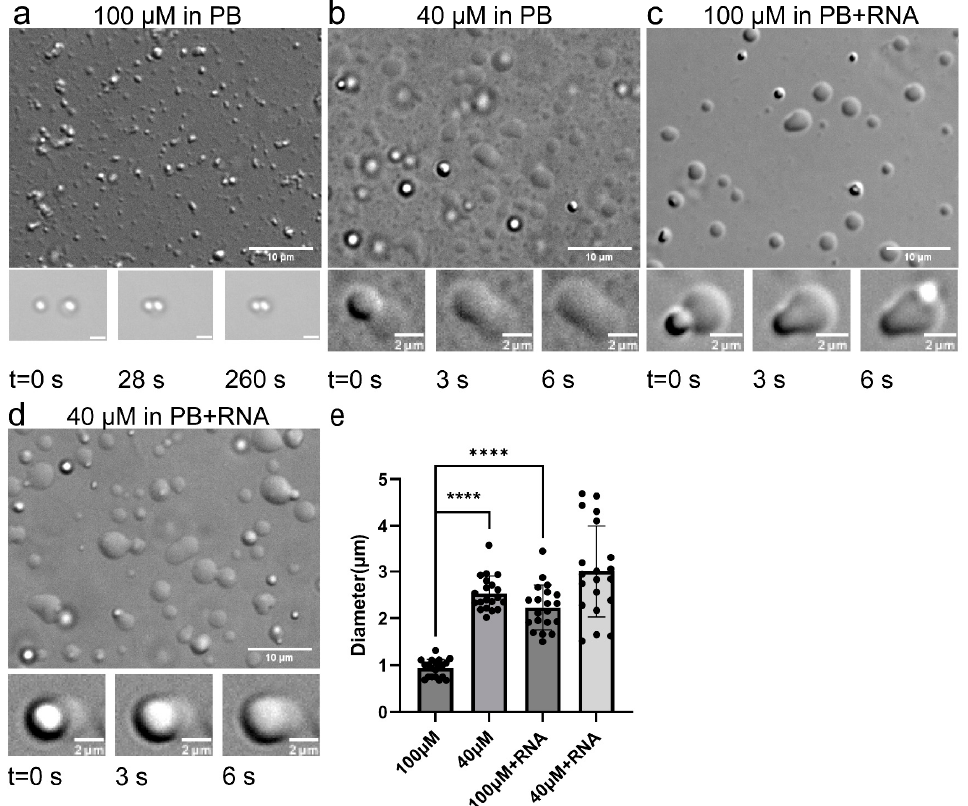
Figure 1. Images of TDP-43 LCD LLPS in four different solution conditions by DIC microscopy. ( a ) 100 μ M in PB, 100 μ M protein concentration in pH 6.0 10 mM phosphate buffer; ( b ) 40 μ M in PB, 40 μ M protein concentration in the same PB buffer; ( c ) 100 μ M in PB + RNA, 100 μ M protein concentration in pH 6.0, 10 mM phosphate buffer with yeast RNA (20 ng/ μ L); ( d ) 40 μ M in PB + RNA, 40 μ M protein concentration in the same PB buffer with RNA. Scale bars are 10 μ m for the larger images. Representative events of TDP-43 LCD droplet fusion are shown at the bottom panel with the scale bar of 2 μ m. The bottom panel of ( a ) shows snapshots from the optical tweezer experiment. ( e ) Statistical analysis of TDP-43 LCD droplet sizes for the four conditions. For each condition, 20 droplets were analyzed from a single image. Statistical differences were determined using an unpaired Student’s t-test; **** p < 0.0001 (GraphPad Prism).